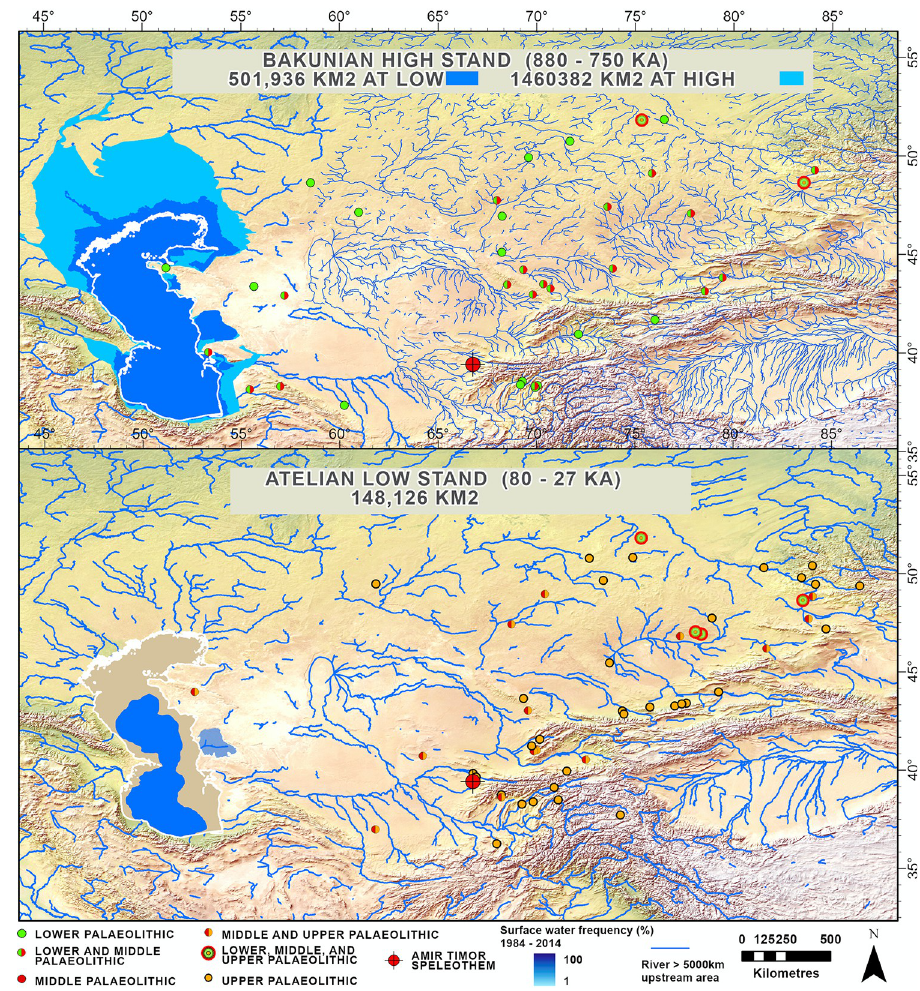
Fig 6. Models of the Bakunian high stand and Atelian low stand water supply calculated by the authors, with paleolithic finds (per [19]). Lower Paleolithic finds are plotted on the map of the Bakunian high stand and Upper Paleolithic finds are plotted on the map of the Atelian low stand. The location of the Amir Timur speleothem is also plotted (red target). Basemap is Natural Earth 2 data.